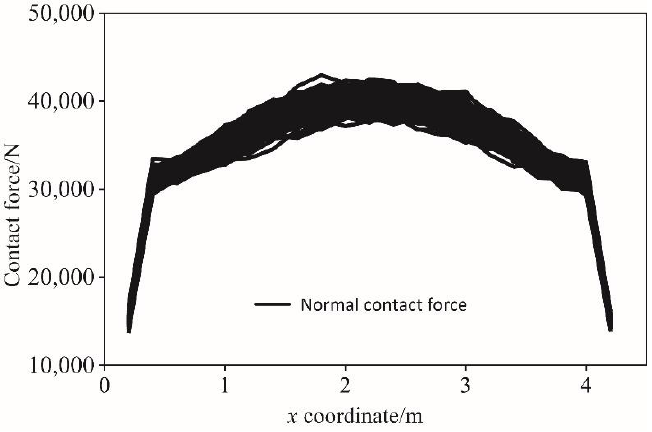
Figure 7. Contact force from 500 realisations when the coefficient of friction is 0.